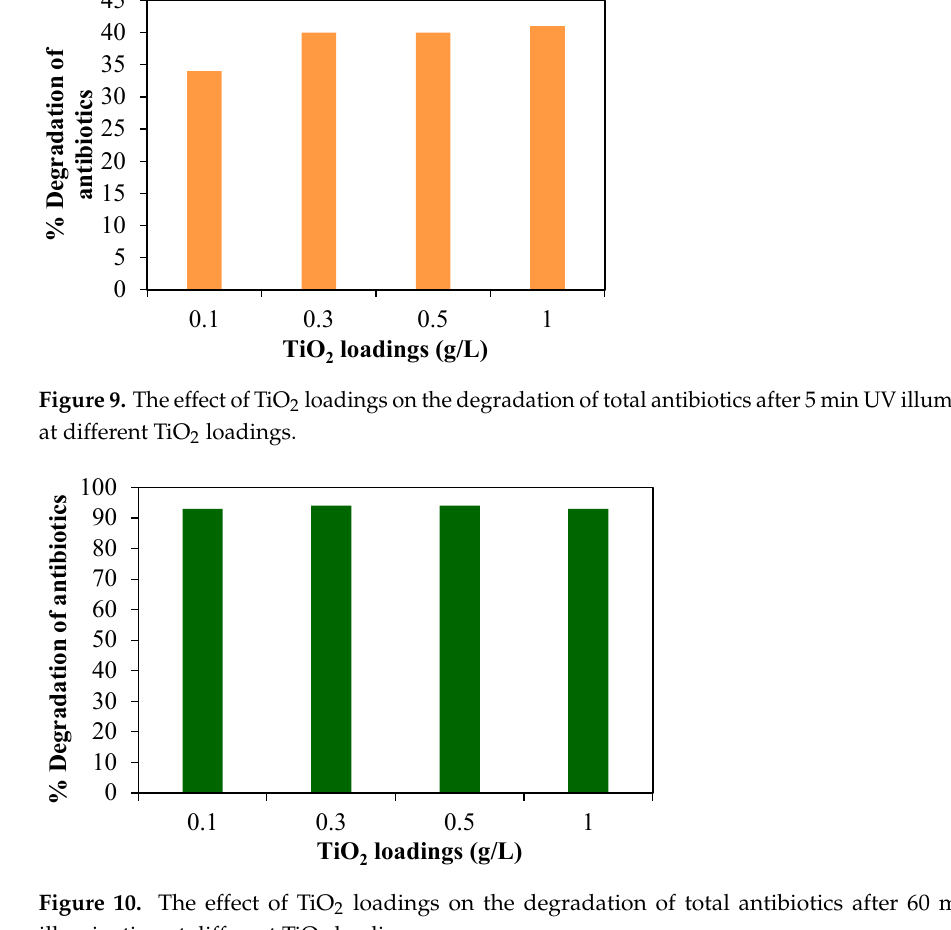
11 of 20 Figure 8. The pH value for 90% degradation efficiency of selected antibiotic by using UV/TiO 2 . [an- tibiotics] 0 = 50 μ g/L, [TiO 2 ] 0 = 0.1 g/L. 3.3.3. Effects of Photocatalyst Loadings The degradation of antibiotics in livestock wastewater by UV/TiO 2 process was car- ried out at different TiO 2 loadings (i.e., 0.1, 0.3, 0.5, and 1.0 g/L) for 60 min of UV illumi- nation, and the results were shown in Figures 9–13. All the seventeen antibiotics were spiked in the reactor to achieve a total concentration of 350 μ g/L. The results showed 34, 40, 40 and 41% degradation of the antibiotic using TiO 2 loadings of 0.1, 0.3, 0.5, and 1.0 g/L, respectively, during 5 min UV illumination (Figure 9). After 60 min illumination, more than 90% of the antibiotics were degraded with all TiO 2 loadings (Figure 10). The highest degradation efficiency was obtained using 1.0 g/L. Meanwhile, the degradation efficiency of the individual antibiotics under UV/TiO 2 process was investigated by using different TiO 2 photocatalyst loadings, and the results were shown in Figures 11 and 12.